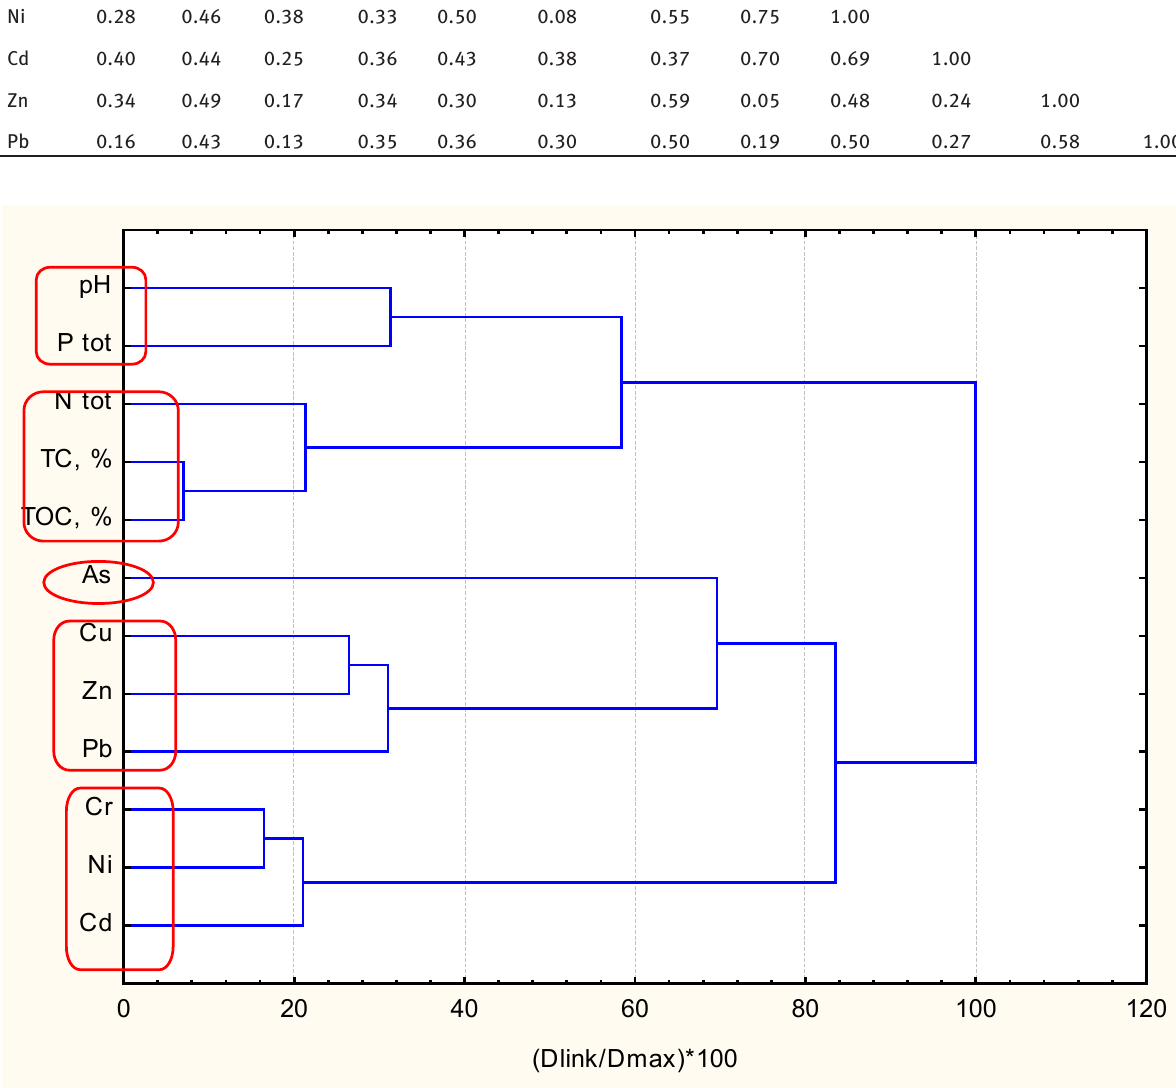
Figure 2: Tree diagram for 12